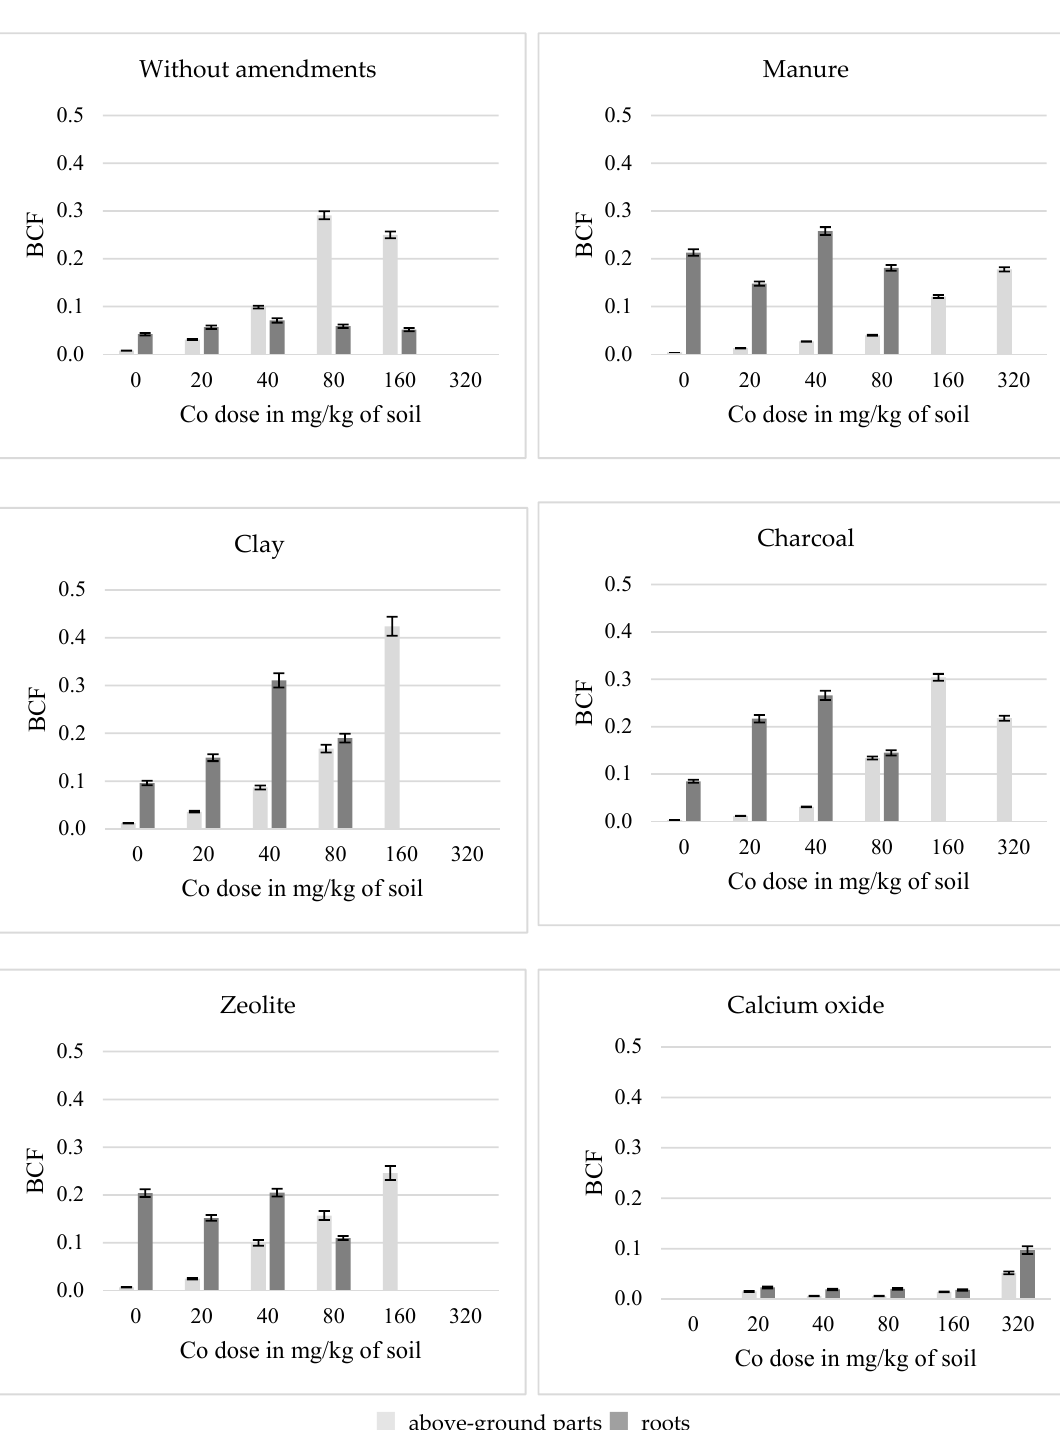
Figure 3. Bioconcentration factor (BCF) of cobalt in white mustard above-ground parts and roots.